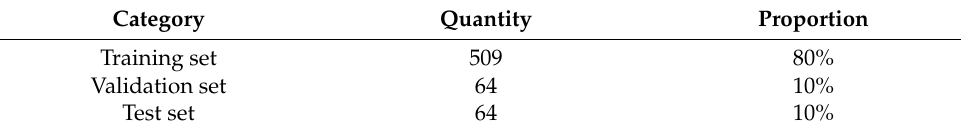
Table 2. Dataset partitioning.